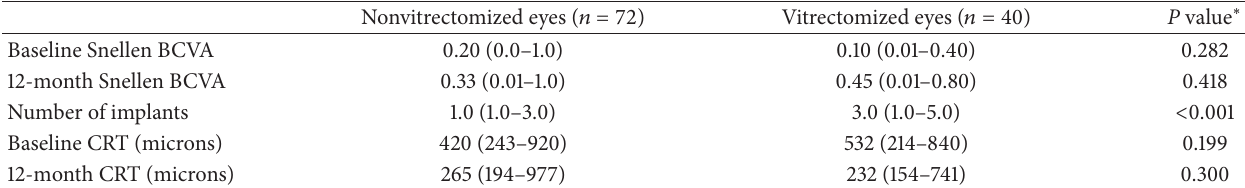
Table 3: Baseline and 12-month BCVA and CRT related to the numbers of implants.